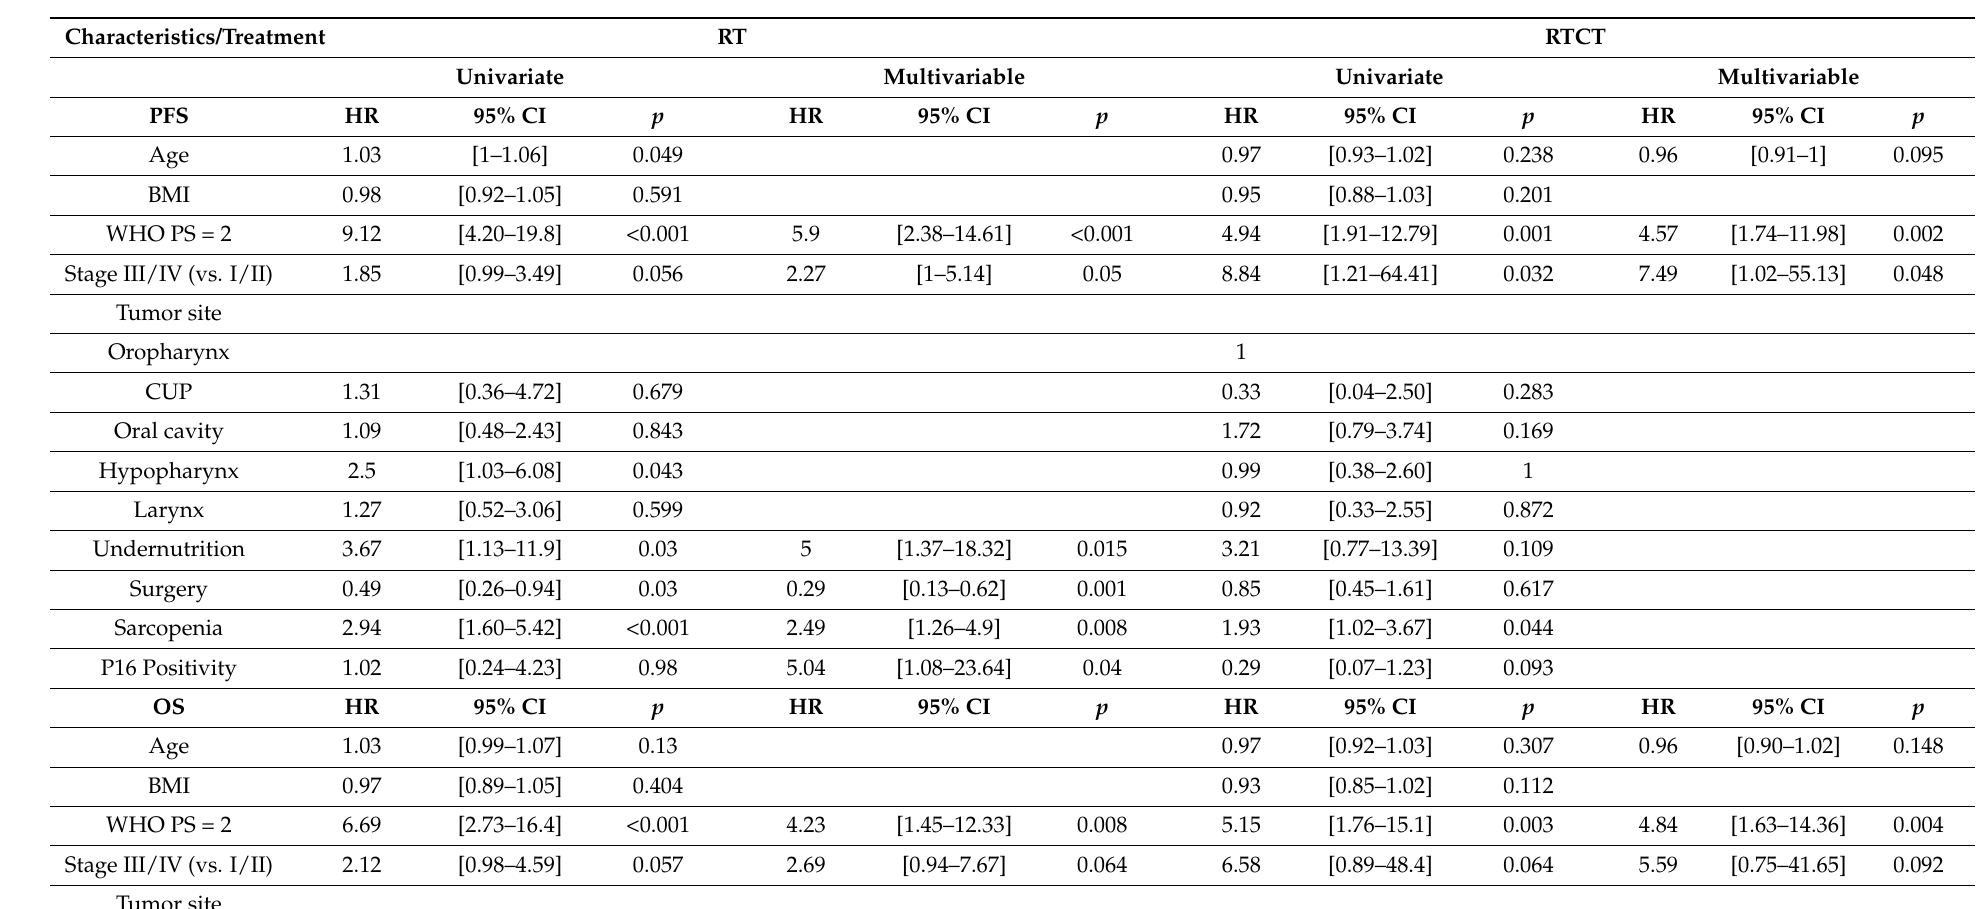
Table 4. Univariate and multivariate analyses of disease-free survival and overall survival according to treatment (RT and